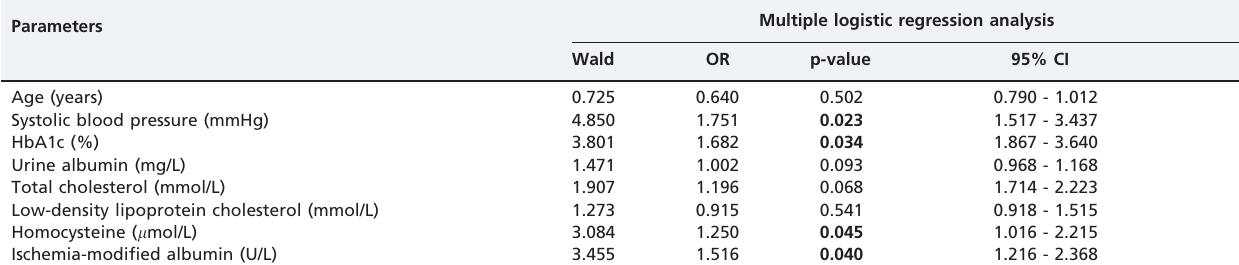
Table 3 - Multiple logistic regression analysis using PAD as a dependent variable with all subjects (n= 290).